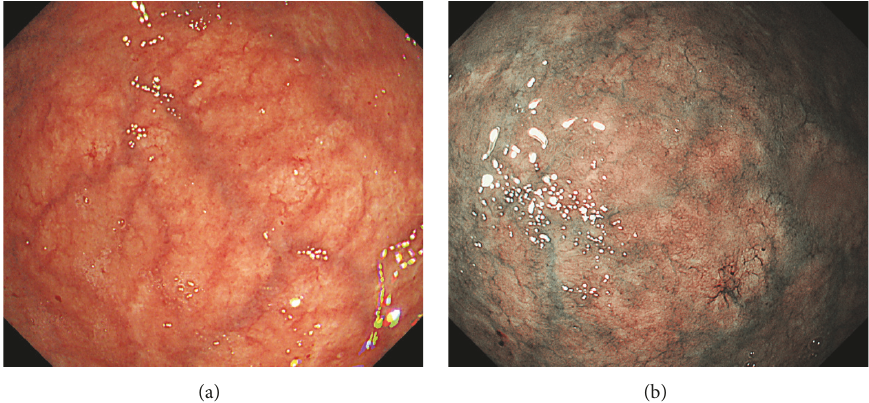
Figure 5: Esophagogastroduodenoscopy images of Case 2. Endoscopy performed 12 months later shows no white substances even in the gastric fornix ((a): white light, (b): narrow-band